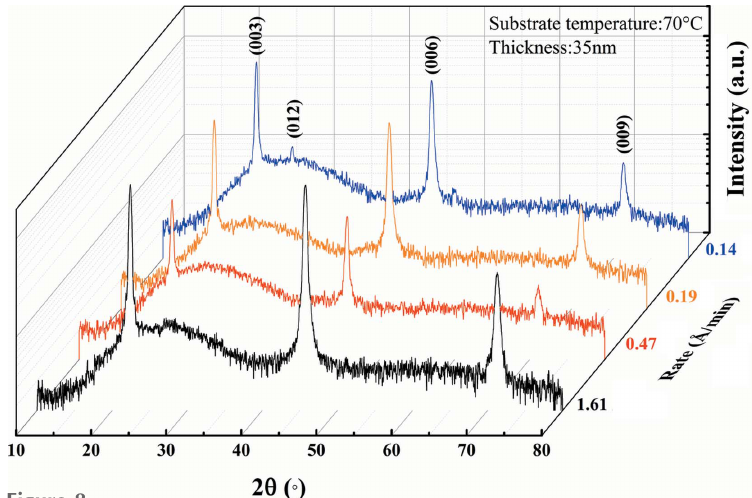
Figure 8 XRD patterns of Bi thin films with different growth rates at 0.14, 0.19, 0.47 and